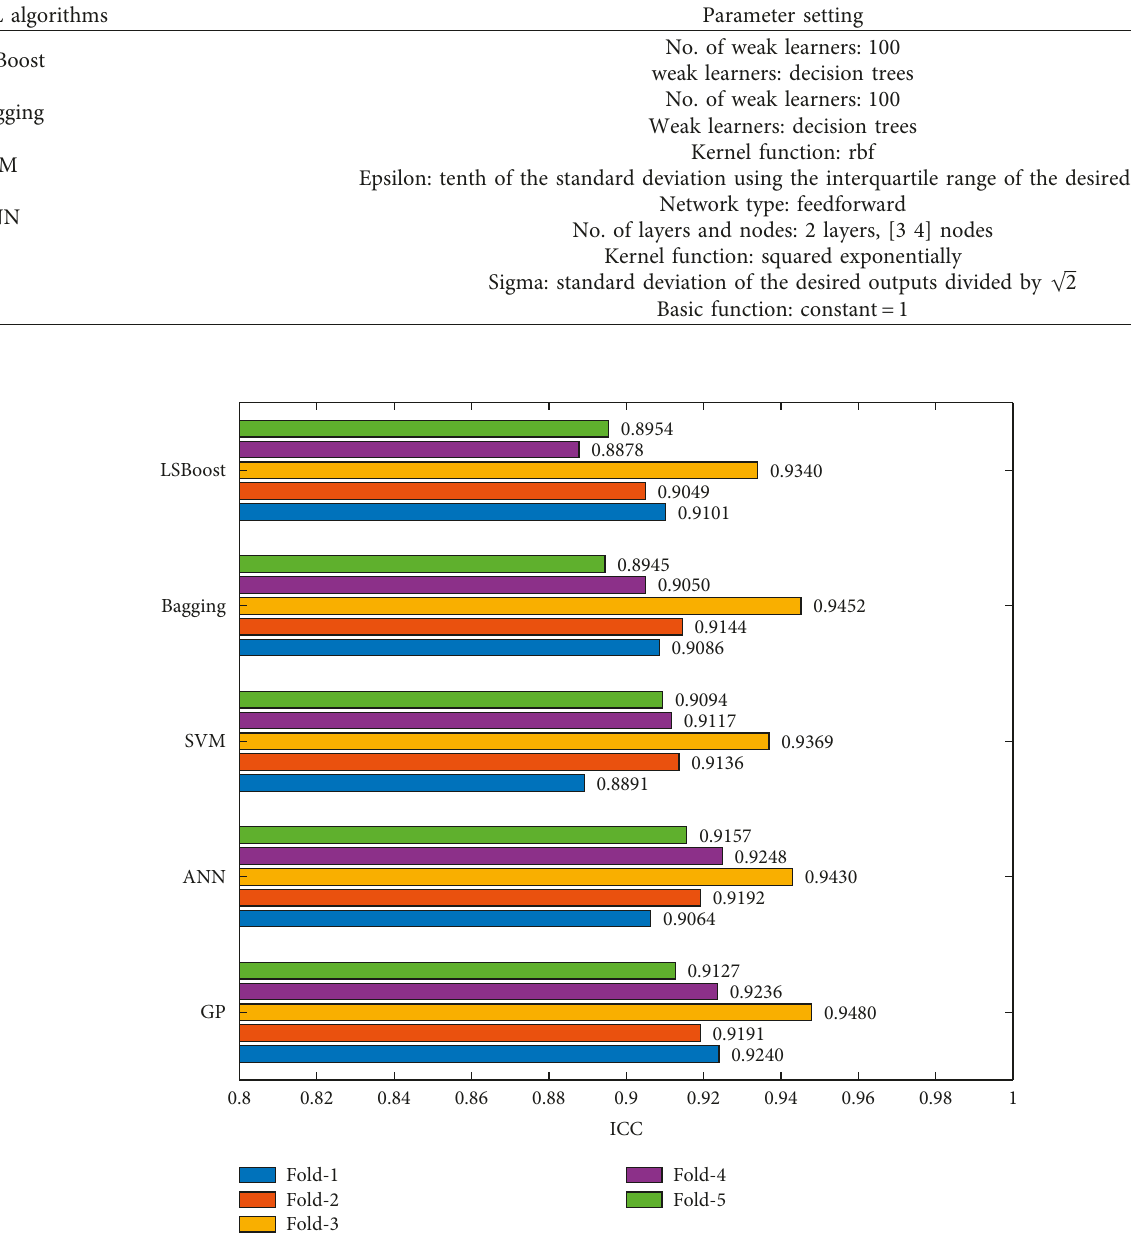
Figure 5: Bar graph showing ICC values from 5